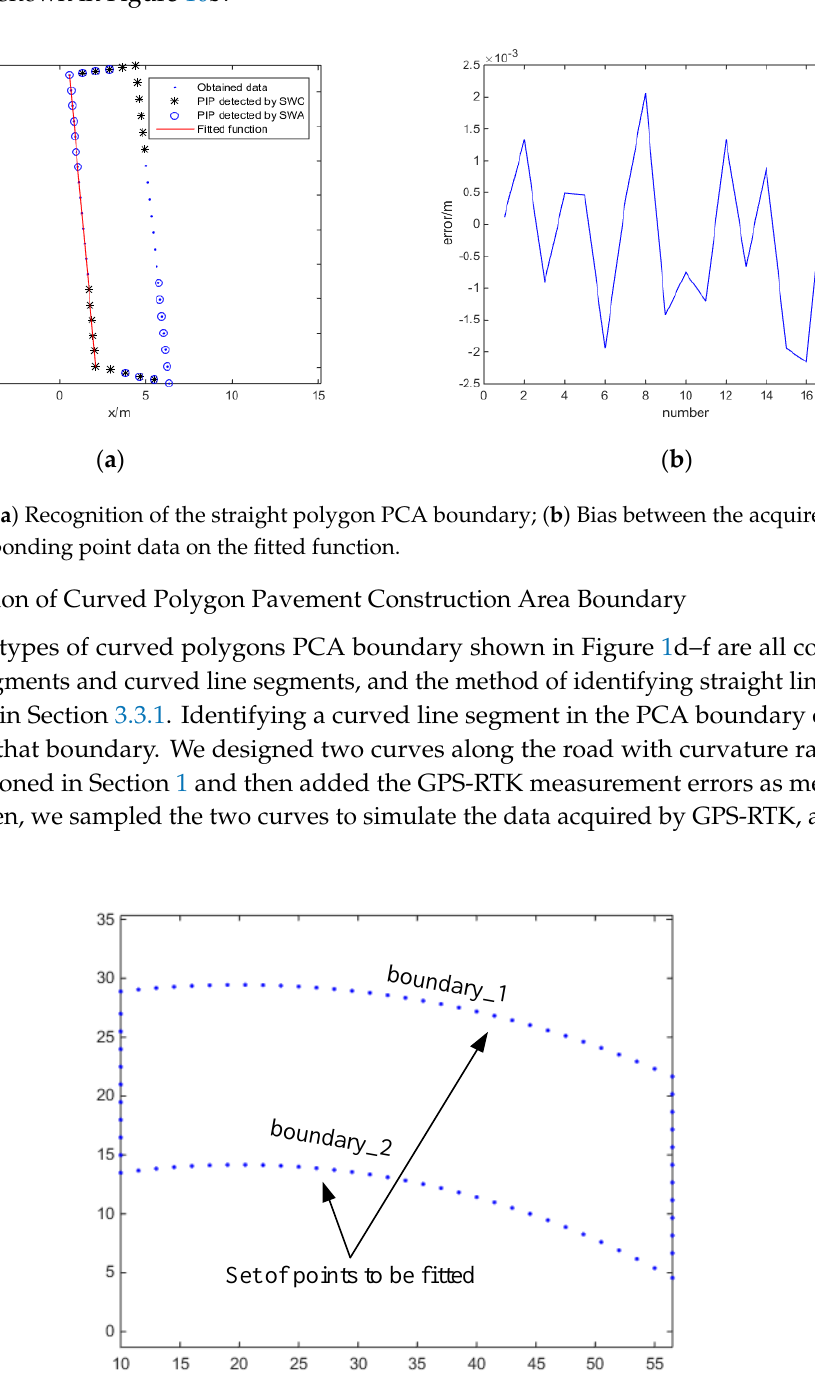
Figure 11. Curved polygon PCA boundary to be